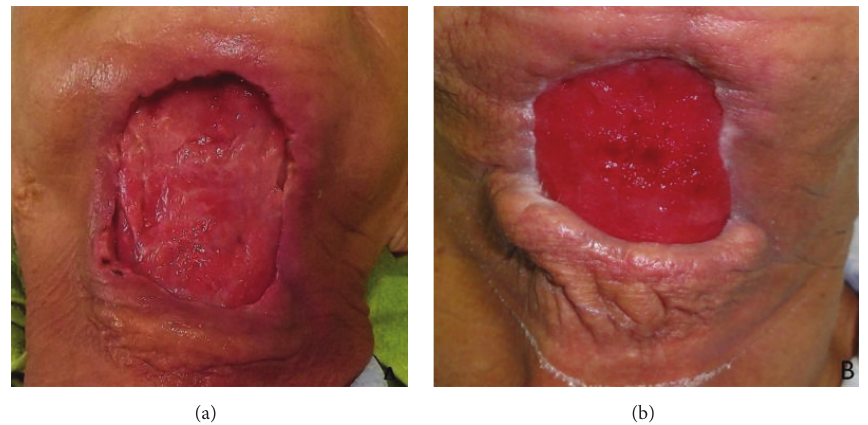
Figure 3: (a) After seven days and (b) after 21 days, dehiscence of the wound edges was observed.